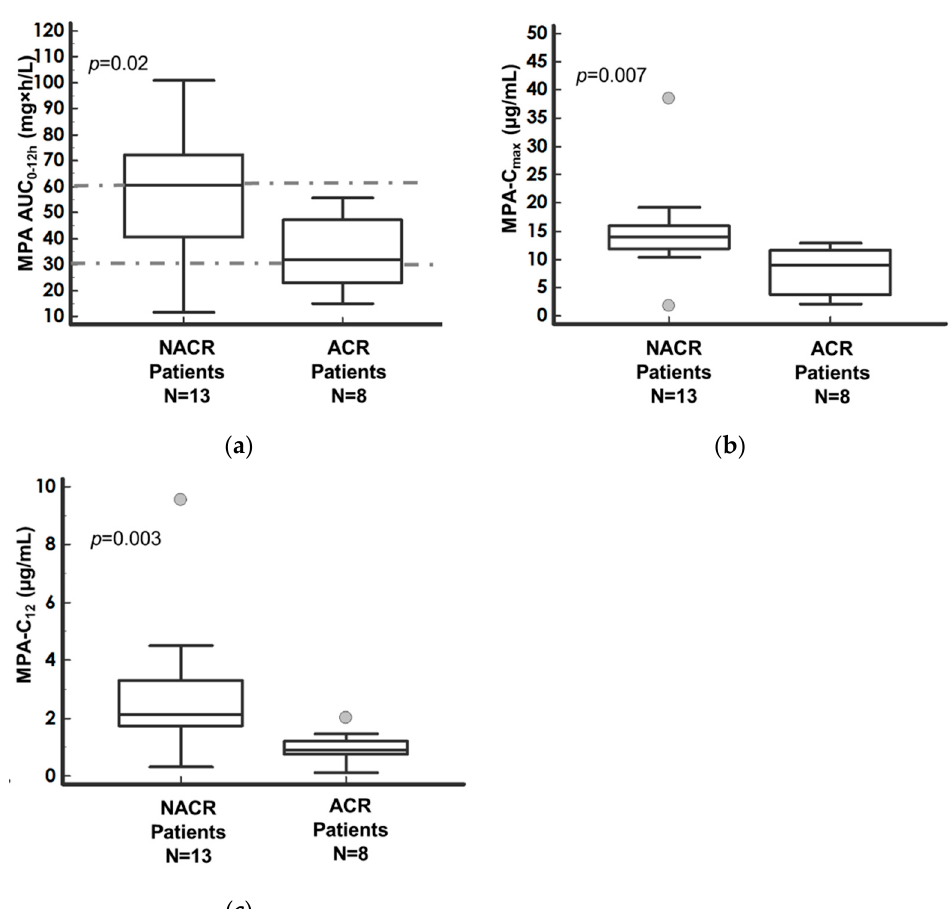
Figure 3. Comparison of ( a ) MPA–AUC 0–12h , ( b ) MPA–C max , and ( c ) MPA–C 12 between NACR and ACR patients and corresponding p- value of the Mann–Whitney test. Median values with the corresponding 95% confidence intervals (bars). In ( a ), the interval between the dotted lines represents the therapeutic range (30–60 mg·h/L). Dots represent the outliers. Nomenclature: AUC 0–12h —area under the 12-h concentration–time curve; C max —peak drug plasma concentration; C 12 —12 h post-dose drug plasma concentration, ACR pts—patients who developed acute cell rejection; NACR pts—patients who did not develop acute cell rejection.